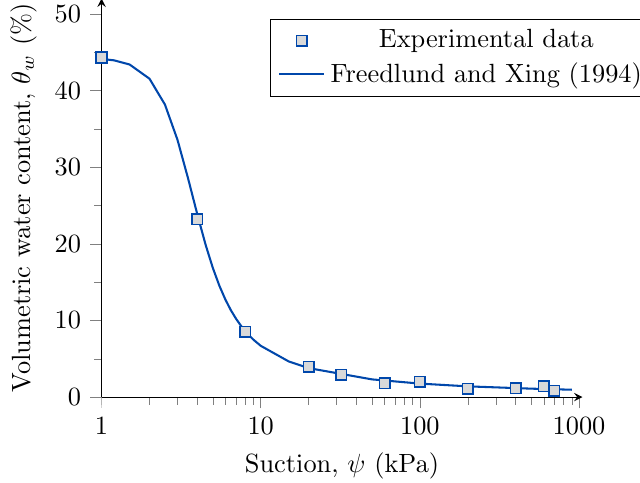
Figure 7. Soil-water characteristic curve.